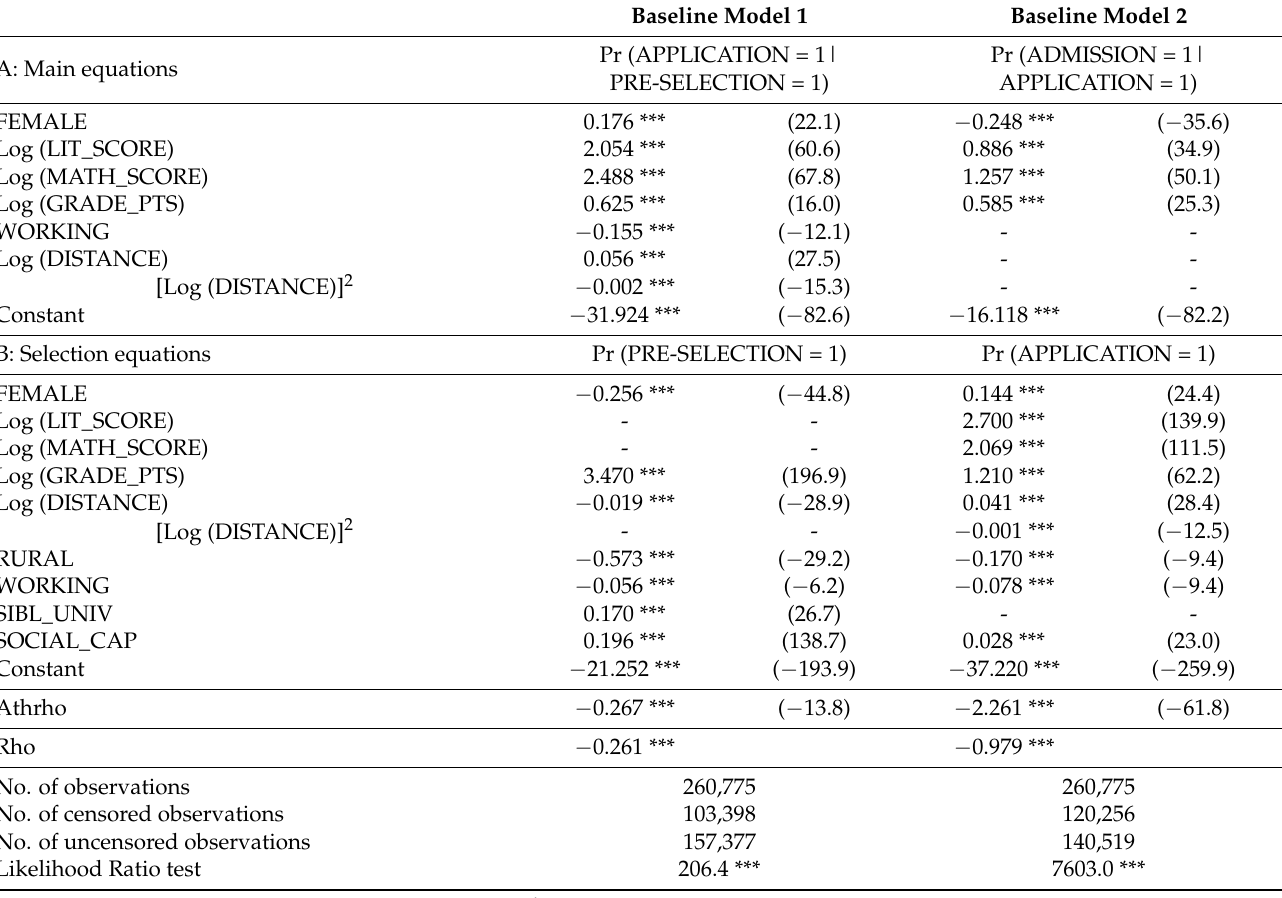
Table 2. Estimated coefficients from Heckman probit—baseline models.